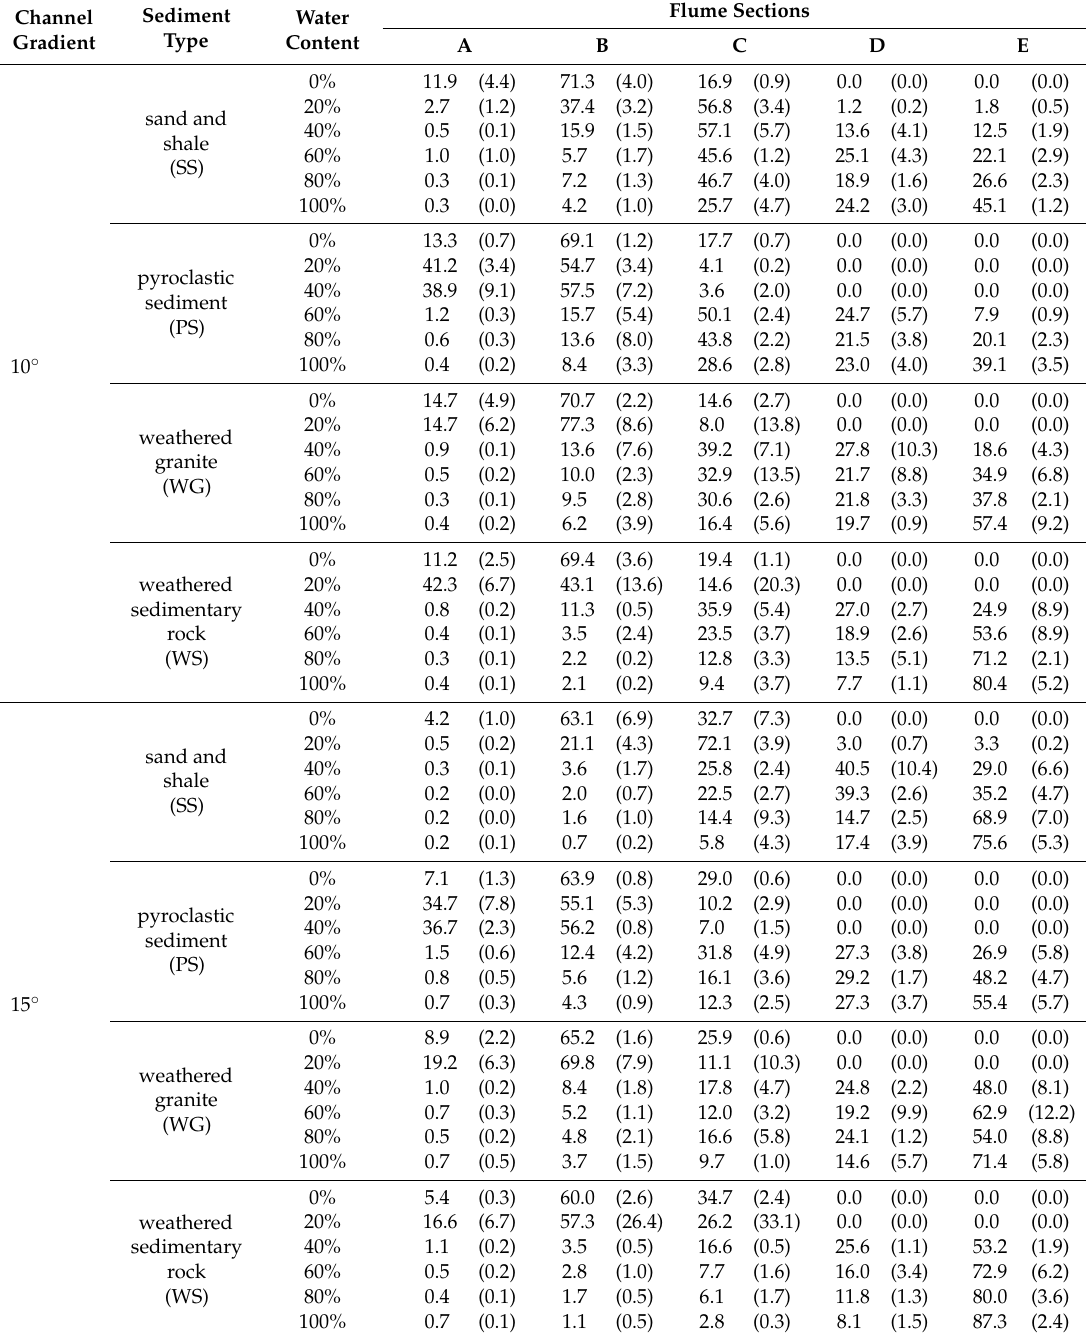
Table A3. Summary of sediment deposition for 60 ◦ inflow angle (in %). Values in parentheses indicate standard